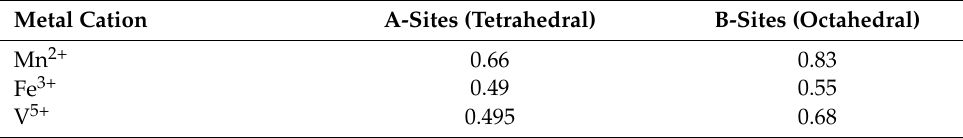
Table 2. Ionic radii (Å) of metal cations in both tetrahedral and octahedral sites [15] .